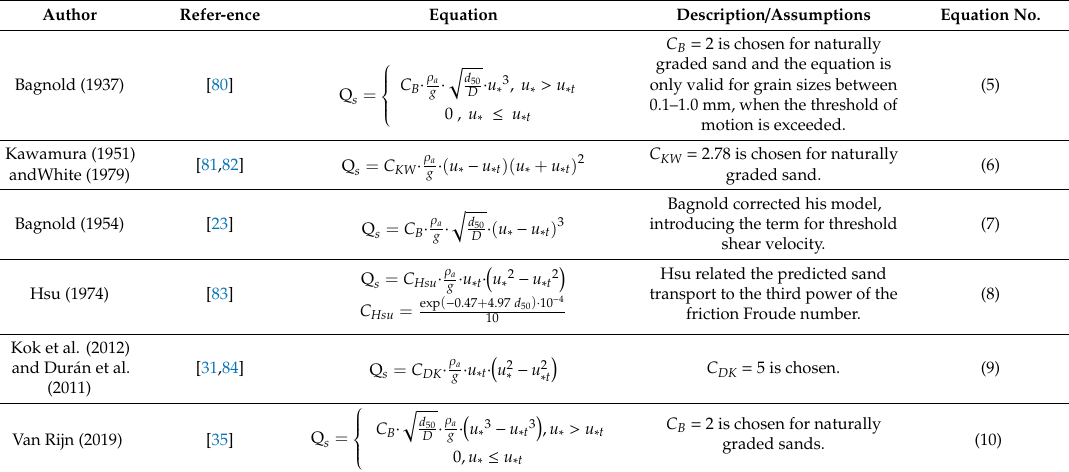
Table 1. Summary of five chosen representative sand transport models for predicting saturated aeolian sand transport rates for dry sand (modified after